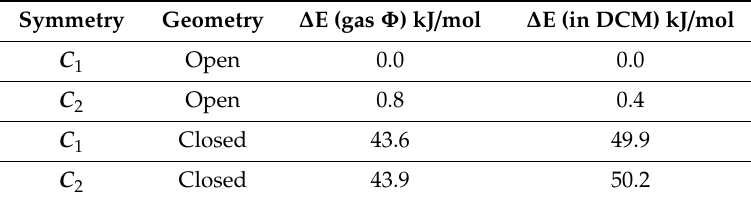
Table 1. Relative Conformer Energies for compound 1.